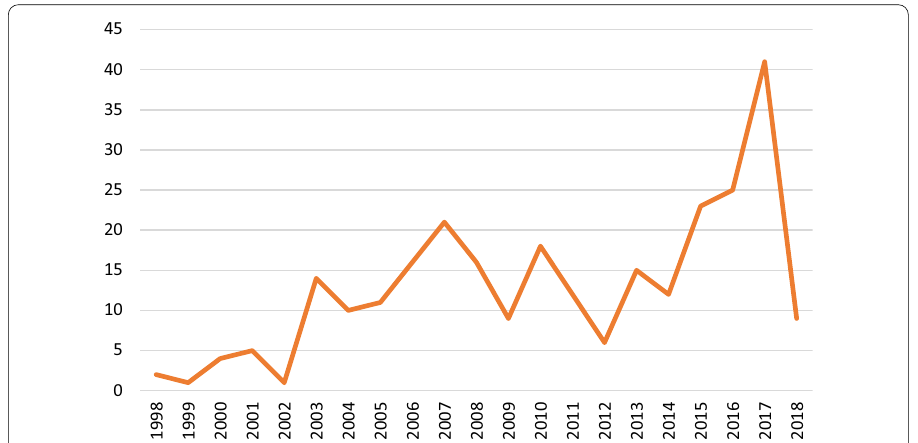
Fig. 1 Suspected MS-13 Murders in the US by year. Source: compiled from US Department of Justice indictments and news